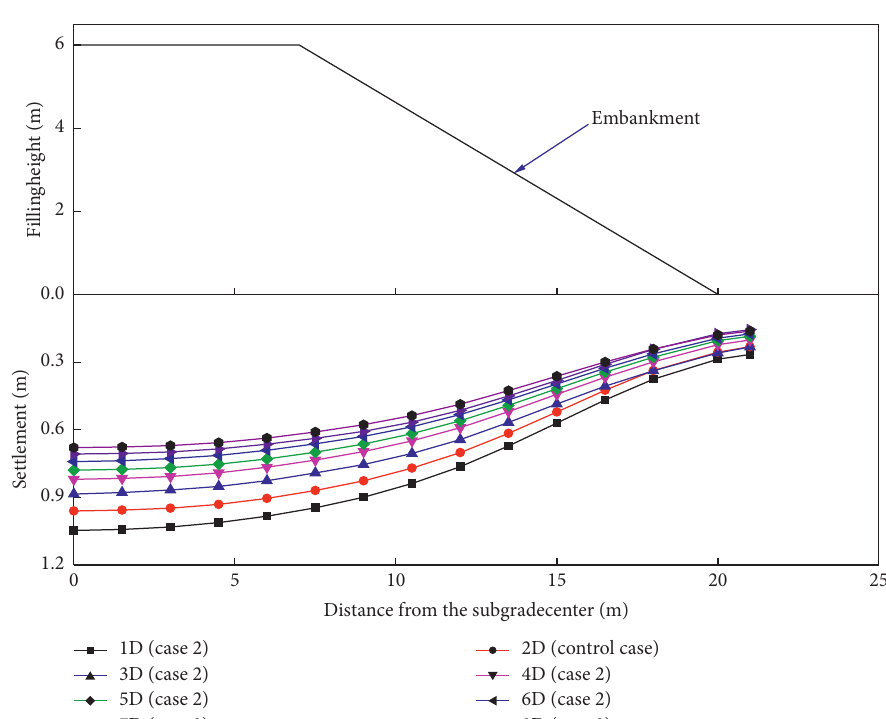
Figure 8: Influence of encasement length on the differential settlement.